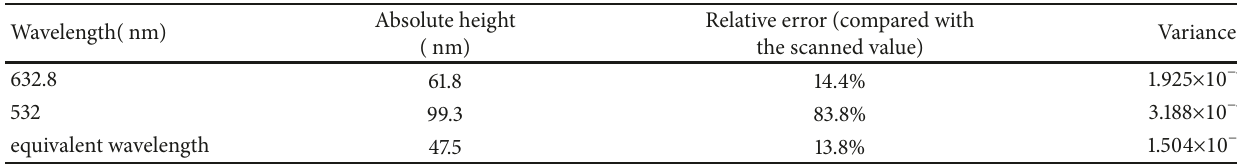
Table 2: The comparison of the height